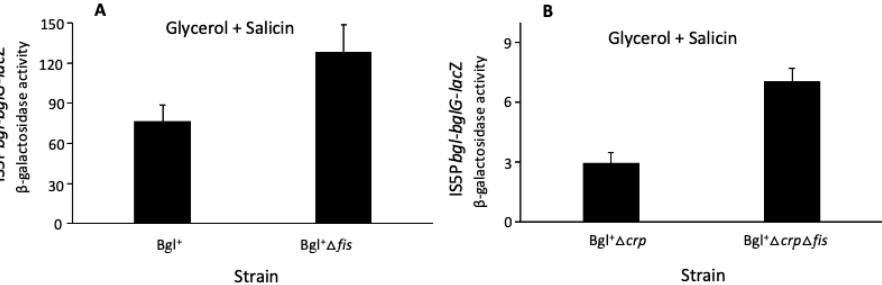
Figure 5. Fis represses bgl operon expression when it is activated by IS insertion. ( A ) Fis repression of bgl operon expression after activation by IS insertion. ( B ) Antagonism between Fis and Crp in regulating the bgl operon. In both ( A ) and ( B ), IS5 insertion is present both in the native operon and the operon lacZ reporter. Cells were cultured in M63 with glycerol and salicin as carbon sources. Sample collection and β -galactosidase assays were carried out as in Figure 1.